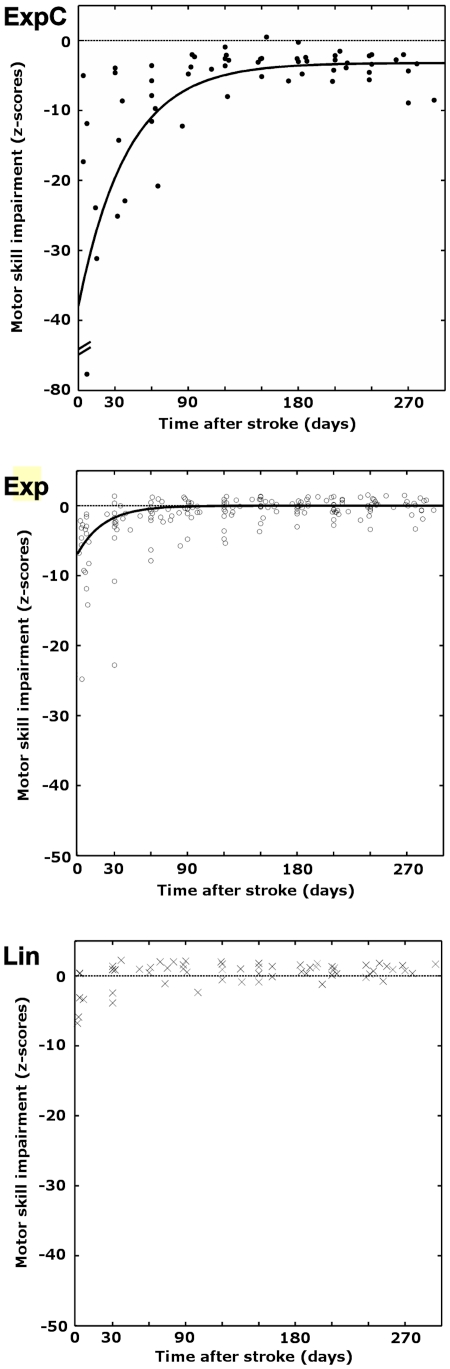
Modeled subgroup recovery trajectories.Scatterplots of subgroup motor impairment scores versus time post-stroke. Impairment scores are in unit standard deviation from the healthy population, where more negative values indicate increasing impairment. Subgroups are named according to the models that best fit their recovery curves. ExpC: patients with slow and impaired recovery (n = 6); Exp: patients with slow and complete recovery (n = 17), and Lin: patients with fast and complete recovery (n = 6). Black solid curves indicate weighted mean recovery trajectories. Dashed line indicates mean of control group performance (z-score = 0).